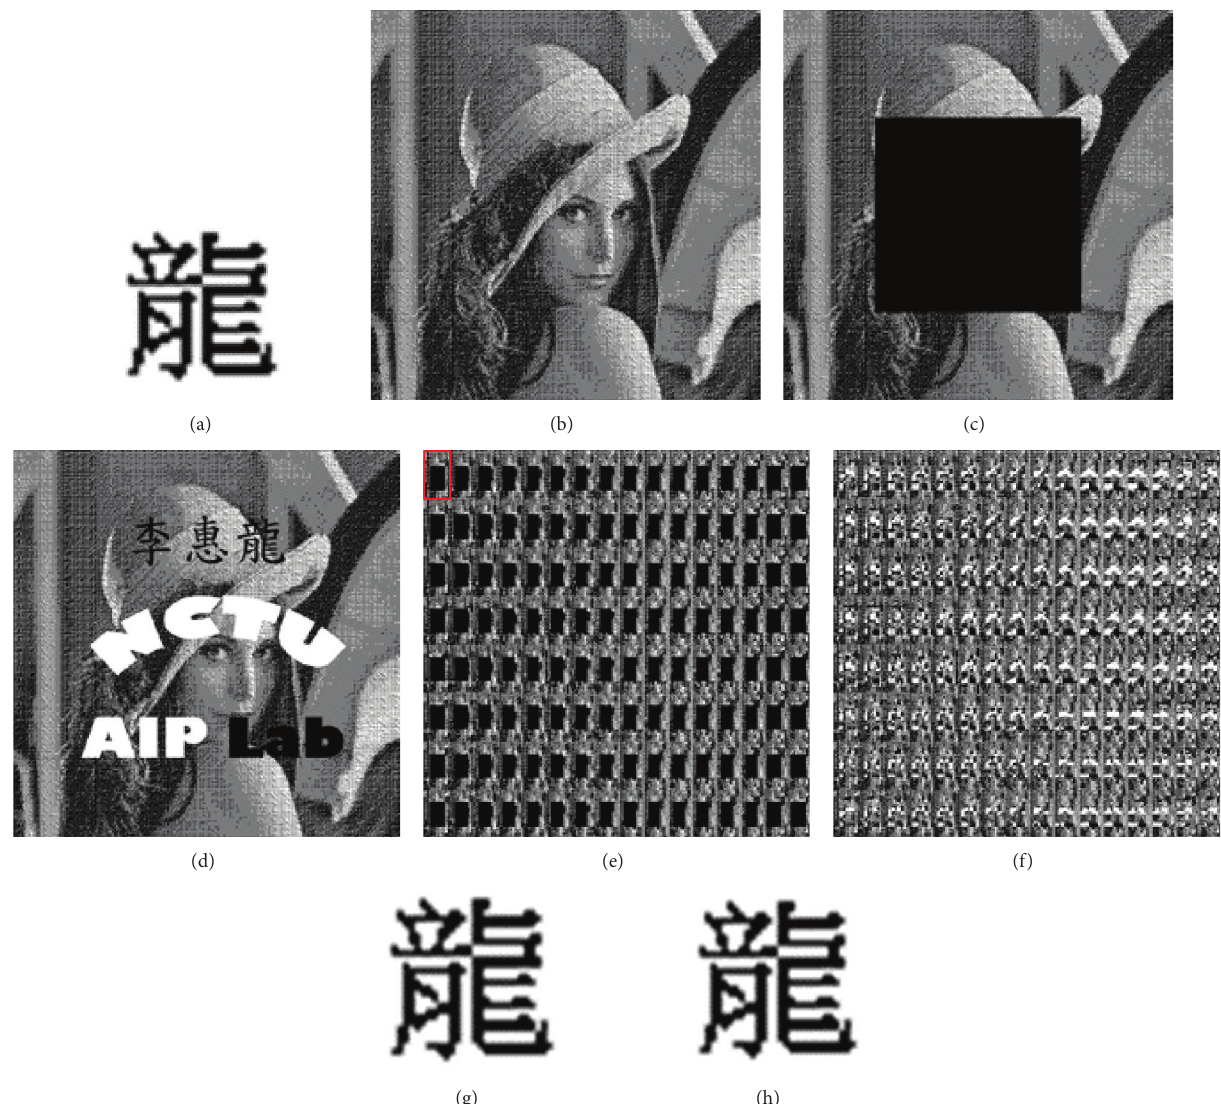
Figure 10: The robustness of the proposed method. (a) A 32 × 32 watermark. (b) Embedded dithered image using the proposed method. (c) Embedded dithered image cropped by 1/4 portion. (d) Embedded dithered image with tampering. (e) Downsampled subimages of (c). (f) Downsampled subimages of (d). (g) The watermark extracted from (c). (h) The watermark extracted from